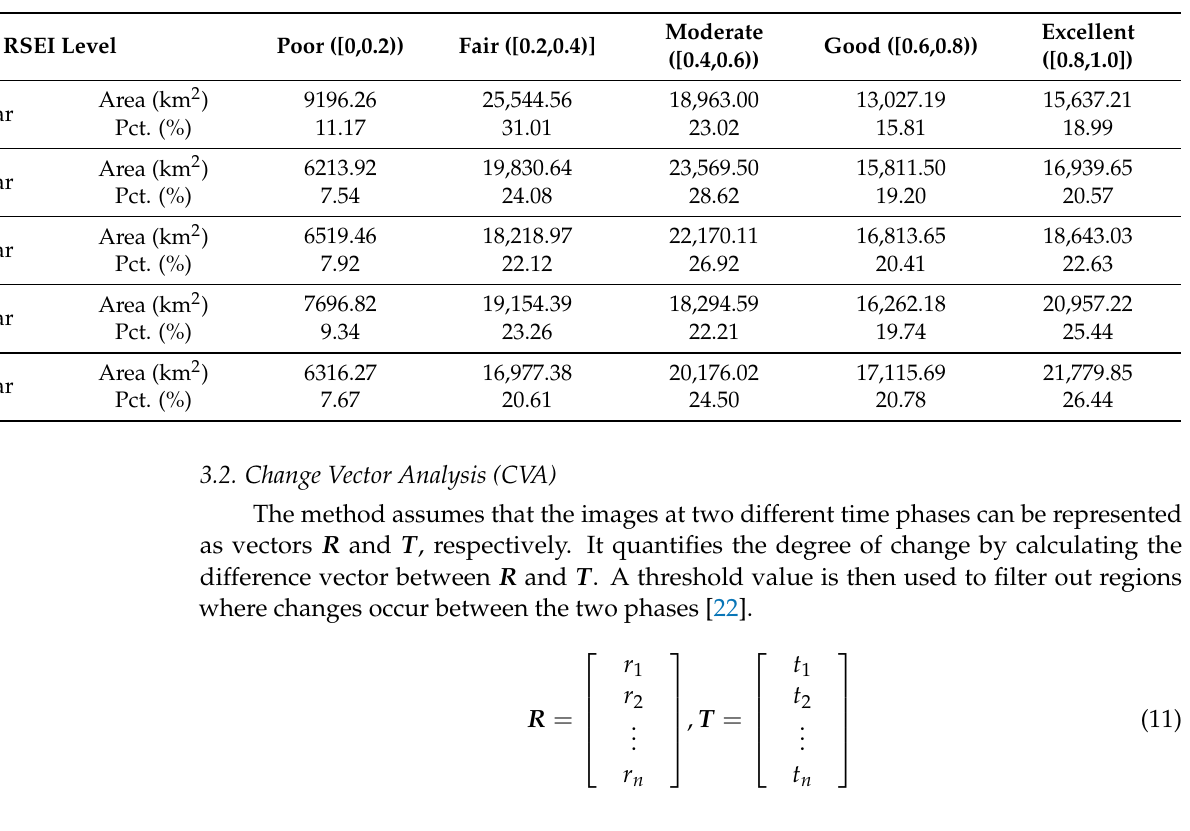
Table 3. The changes in ecological quality levels and their corresponding areas in the study area over different